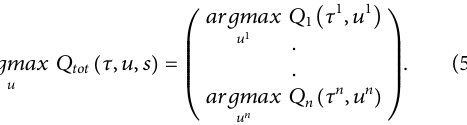
QMIX (Figure 4): QMIX serves as a representative value decomposition technique and works based on the principles of centralized training decentralized execution (CTDE). QMIX is primarily dependent on the mixing network to deal with the credit assignment problem. The mixing network receives the outputs of the individual agents ’ Q-networks Q a ( T a , u a ) to assign the individuals the credits and approximate the global Q-value Q tot ( T , u , s ; θ ). QMIX guarantees the individual-global maximum (IGM) principle, meaning that optimal local decisions jointly lead to the optimal joint decision for Q tot .